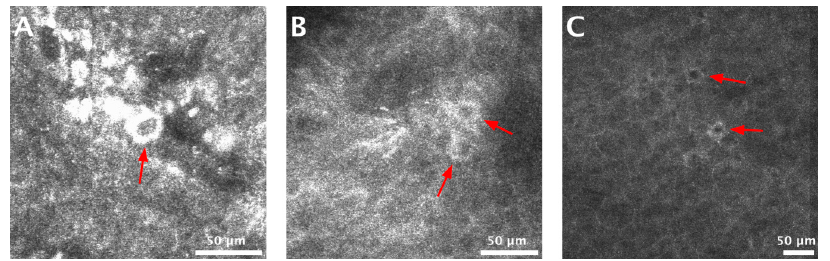
Figure 2. Target cells in the epidermis of actinic cheilitis (AC) lesions. ( A – C ) Reflectance confocal microscopy (RCM) images showing target cells (red arrows), corresponding to dyskeratotic keratinocytes, at the level of the epidermis in AC lesions. Table 5. Specific RCM features associated with AC and lip SCC.